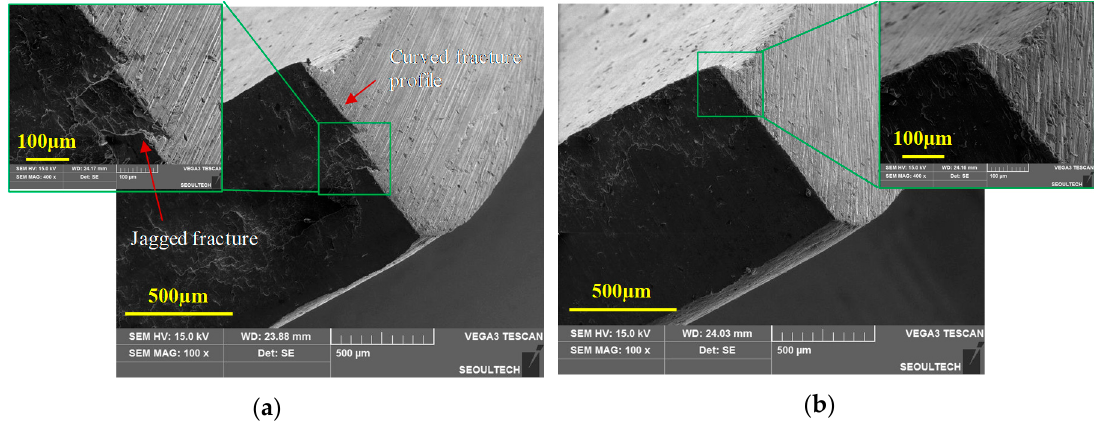
Figure 12. Oriented view (SEM) of the blanked edge obtained from experiments for 20% clearance at ( a ) 100 °C, illustrating jagged-plus-curved fracture profile, and ( b ) 250 °C, illustrating smooth sheared edge.